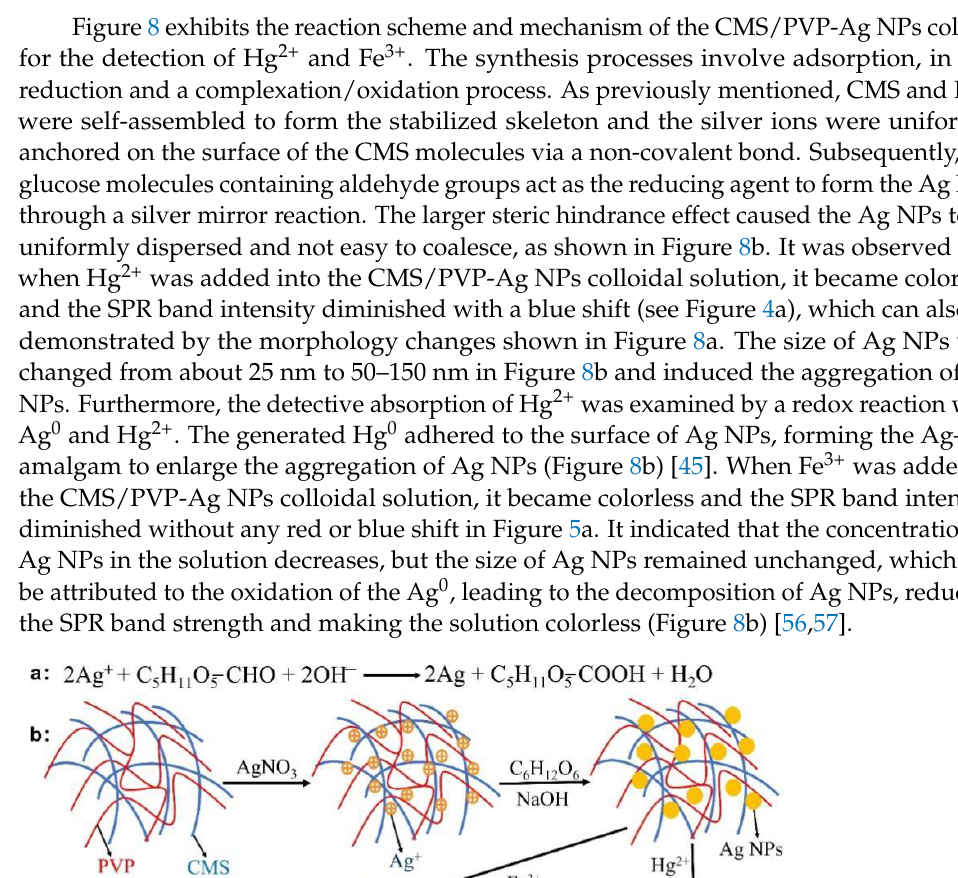
Table 1. Determination of Hg 2+ in tap water and sea water samples.